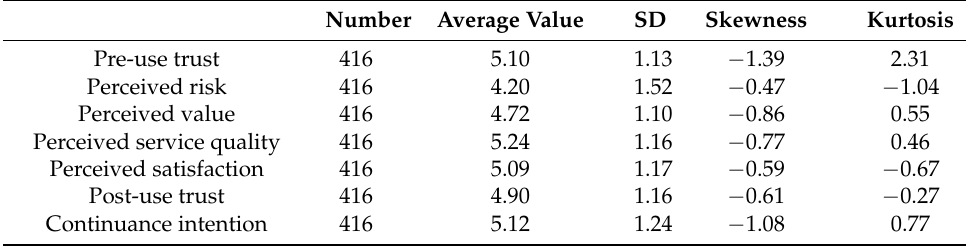
Table 3. Descriptive analysis and normal distribution test of dimension items.